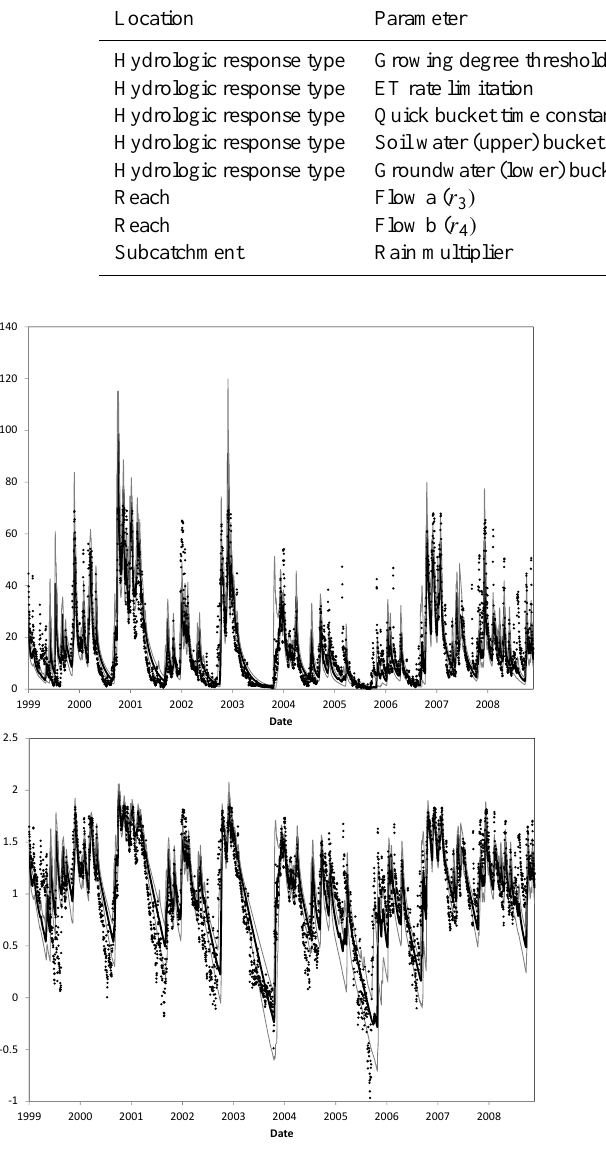
Fig. 6. (a) Observed (dots), maximum average and minimum sim- ulated flows at Pinkhill, the uppermost flow measurement site in the Thames (reach 1). (b) Plot of log 10 transformed observed (dots), minimum, average and maximum modelled flows at Pinkhill (reach 1).